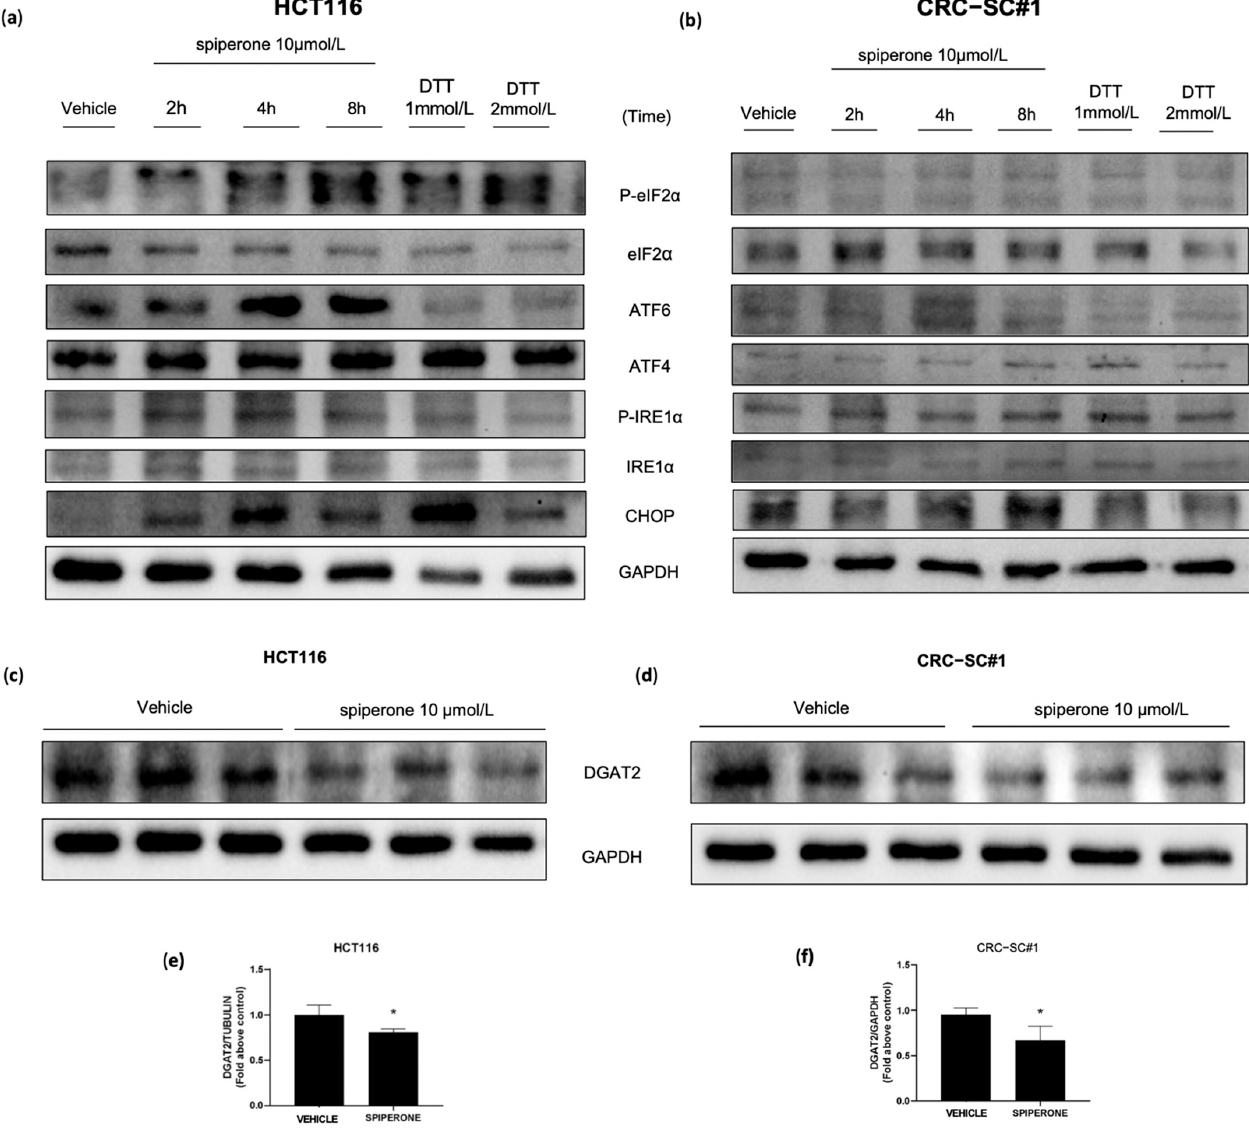
Figure 8. Spiperone induces ER stress in CRC cells. Western blot analysis of HCT116 cells ( a ) and CRC-SC#1 ( b ) after 2, 4 and 8 h of treatment with spiperone. Lysates were analyzed for P-eIF2 α , eIF2 α , ATF4 ATF6, P-IRE1 α , IRE1 α , CHOP, and GAPDH. Data are representative images of three independent experiments. Western blot analysis of DGAT2 protein in HCT116 ( c ) and CRC-SC#1 cells ( d ). After 20 h treatment with 10 μ mol/L spiperone, lysates were analyzed for DGAT2 and GAPDH. Histograms displaying DGAT2 quantification in HCT116 cells ( e ) and CRC-SC#1 cells ( f ). Data are presented as the mean ± SD from three independent experiments. *: p < 0.05.